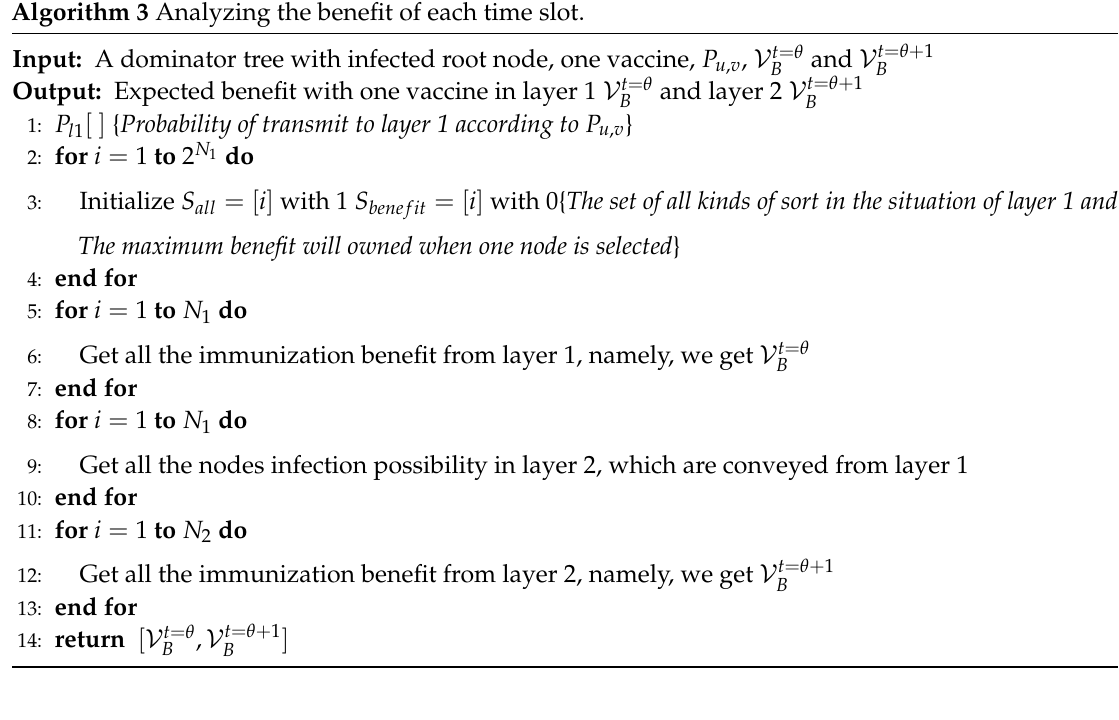
Algorithm 4 DWPV